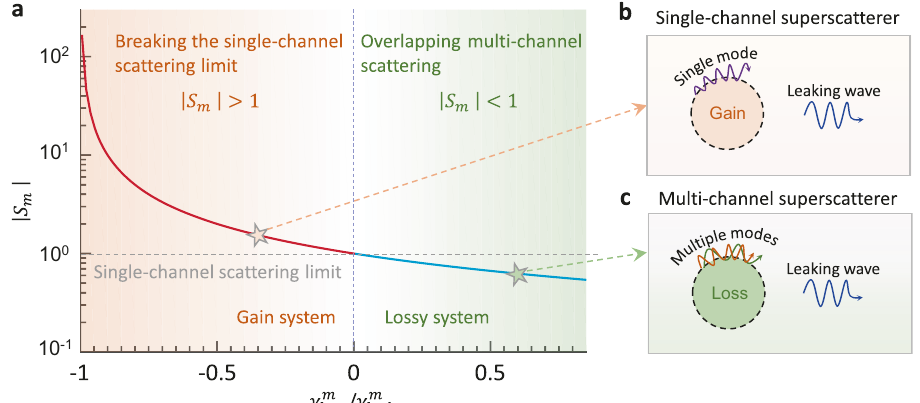
Fig. 1 | Breakdown of the single-channel scattering limit by exploiting gain materials. a Scattering cross-sectionfrom anindividualchannel m asafunction of γ m = γ m based on the temporal coupled theory, where γ m loss leak intrinsic loss rate and external leakage rate, respectively. Conventional scattering- enhanced works mostly focus on the right shaded green region ( γ m system),whichisfundamentallyboundedbythesingle-channelscatteringlimit,i.e., | S m | <1. Morecrucially, the desired performances are oftenhindered by the lackof